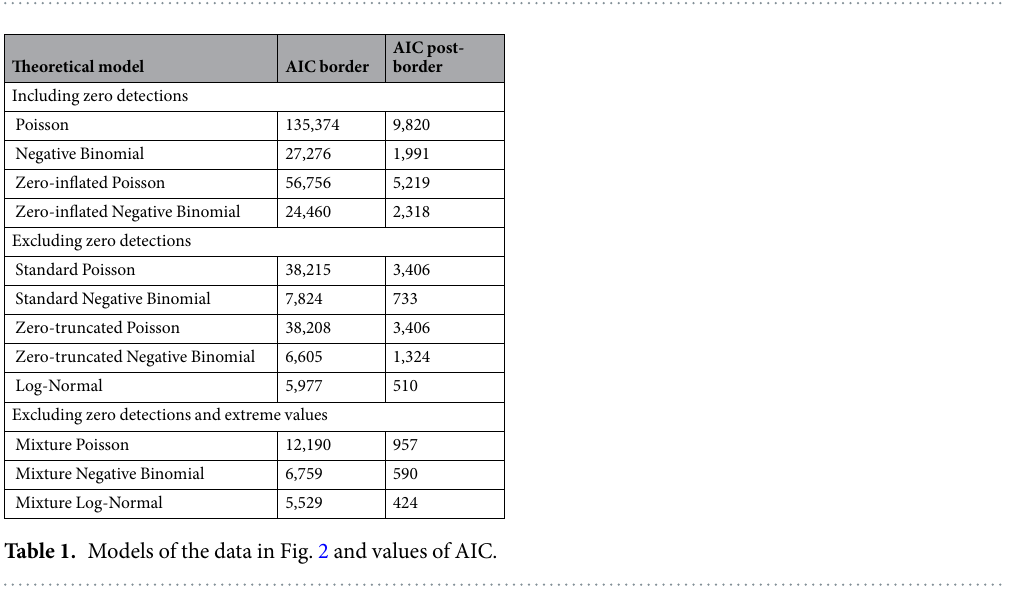
quency distribution observed for border data was similar to that of post-border data (Fig. 2). The log-normal and